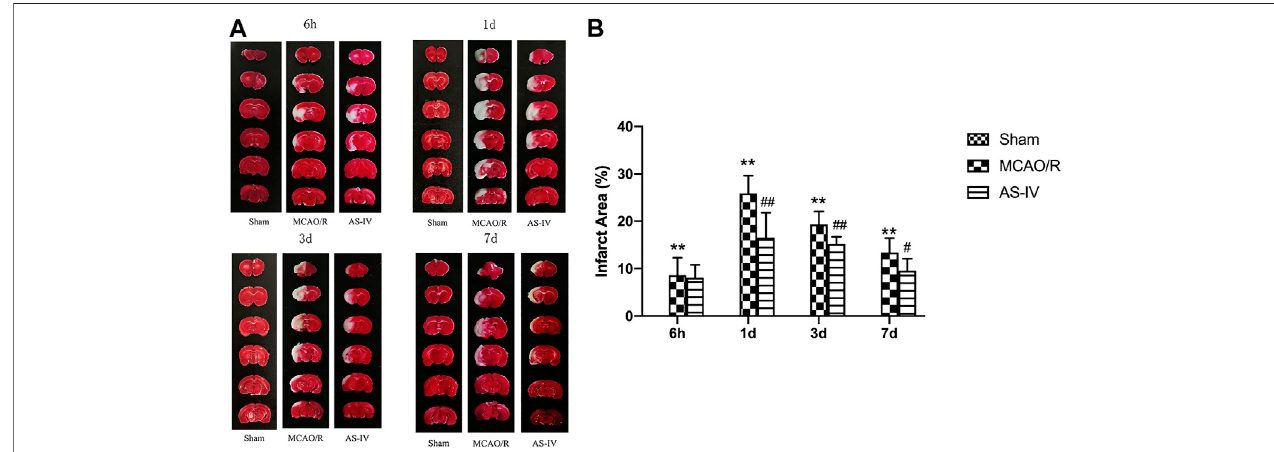
FIGURE3| ThecerebralinfarctionareasinShamgroup, MCAO/R groupand AS-IVgroupat 6h, 1d,3d,and 7days afterCIR injuryinrats(mean ± SD, n (cid:1) 6). (A) TTC staining (B) Quantitative analysis for the percentage of the infarction area. ** p < 0.01, compared with the Sham group; # p < 0.05, ## p < 0.01, compared with the MCAO/R group.